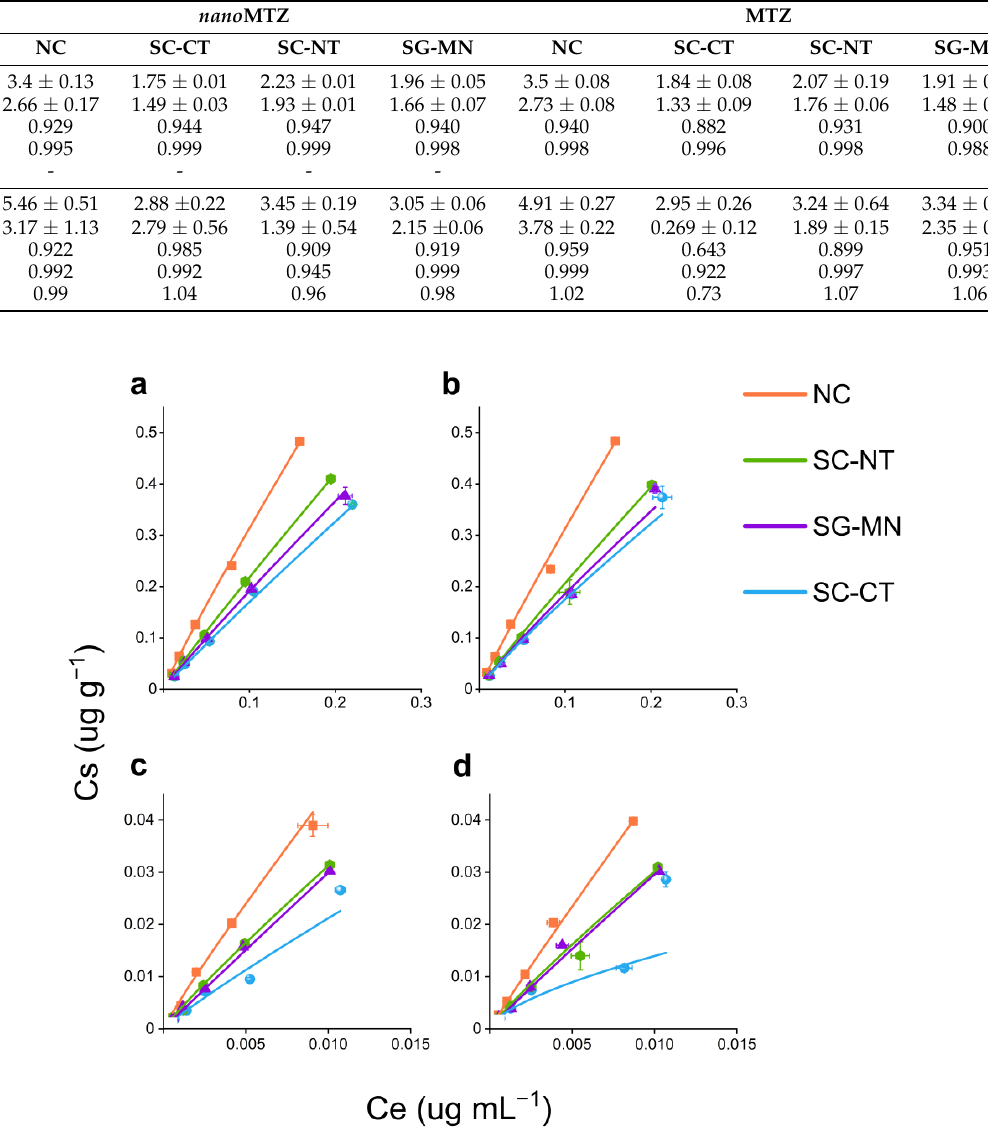
Figure 2. Sorption ( a , c ) and desorption ( b , d ) isotherms for nano MTZ and MTZ, respectively, in different soil systems (non-crop soil—NC, cultivated soil with soybean–corn succession in a no-tillage system — SC-NT, cultivated soil with soybean – corn succession in a conventional tillage system — SC- CT, and sugarcane monoculture soil — SG-MN). Symbols represent Kd values (Cs/Ce) ± mean stand- ard error ( n = 2). Lines represent the curve for each soil system according to the Freundlich model. Pearson ’ s correlation matrices and correlation coefficients (r) between sorption – de- sorption of nano MTZ and conventional MTZ with soil properties are represented in Figure 3